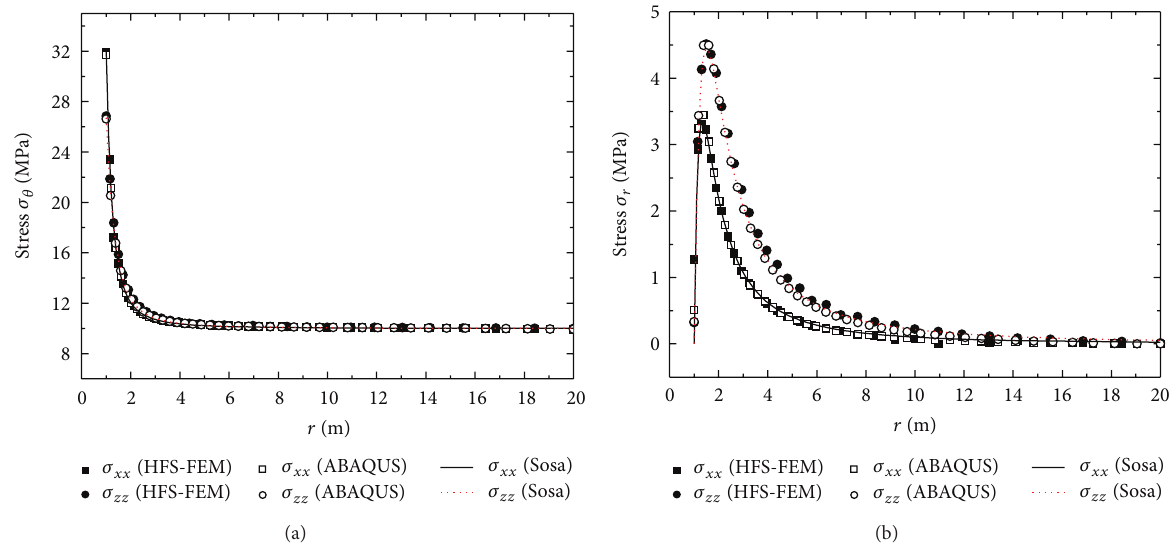
Figure 24: Distribution of (a) hoop stress 𝜎 𝜃 and (b) radial stress 𝜎 𝑟 along the line 𝑧 = 0 when subjected to remote mechanical load 𝜎 ∞ 𝑥𝑥 and along the line 𝑥 = 0 when subjected to remote mechanical load 𝜎 ∞ 𝑧𝑧 .